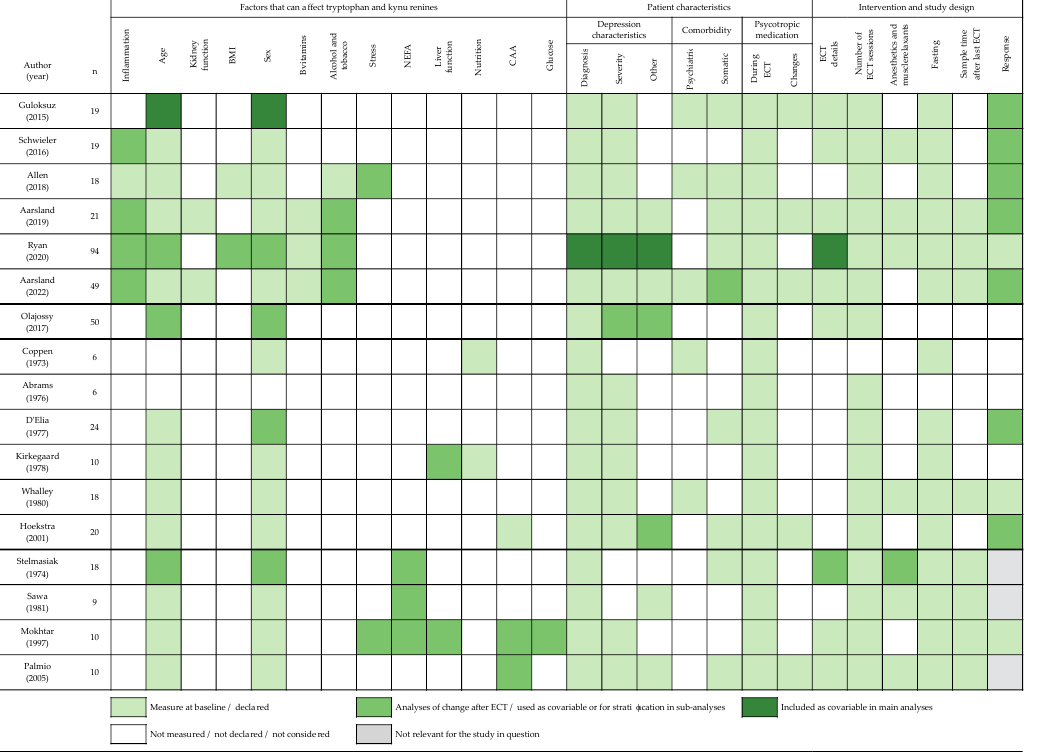
Figure 5. Simplified overview of the review studies’ declaration and handling of factors that can affect analyses of tryptophan and kynurenines in the context of ECT. The table is limited to factors that have been included in at least one of the reviewed studies. See Supplementary Table S2 for a detailed version with more information about the reported data for each study. Abbreviations: BMI, body mass index; CAA, competing amino acid; ECT, electroconvulsive therapy; NEFA, non-esterified fatty acid. References: Guloksuz (2015) [33], Schwieler (2016) [34], Allen (2018) [36], Aarsland